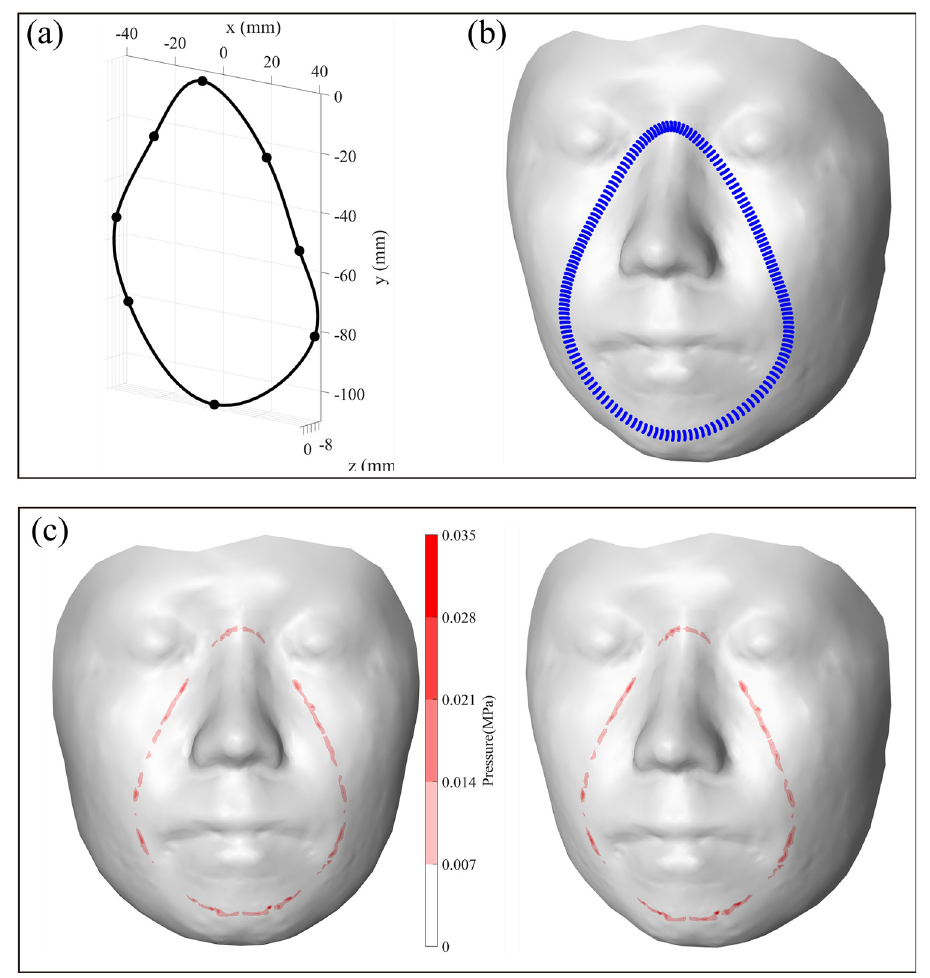
Fig 7. (a) Initial design of the mask generated by the cubic spline function computed using eight reference design points, (b) mask nodes along with the initial design, and (c) contact pressure